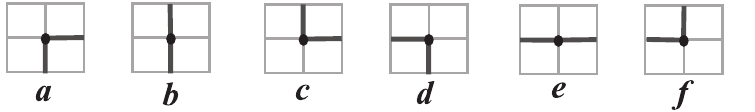
Figure 6. RI of a 2-factor for TG flat representation (in the middle).